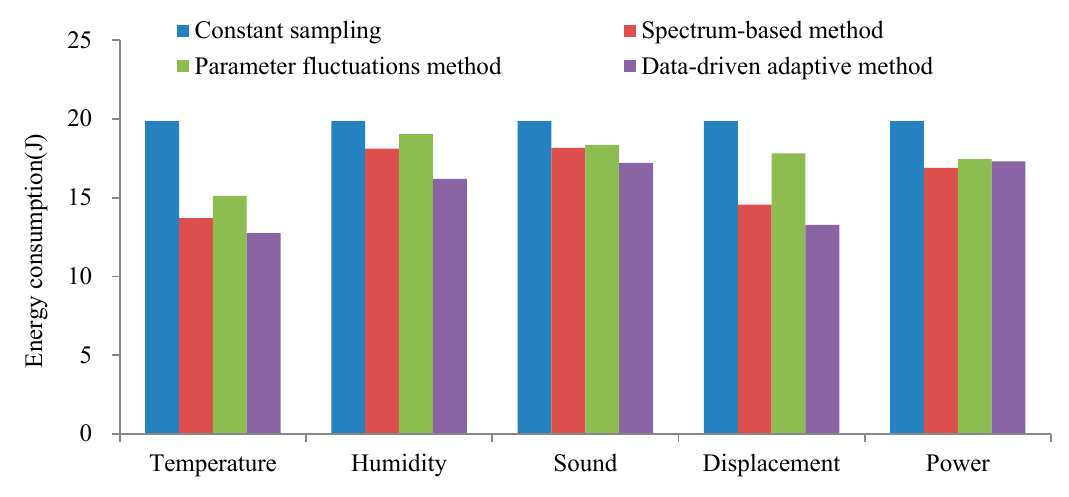
Figure 11. The energy consumption.